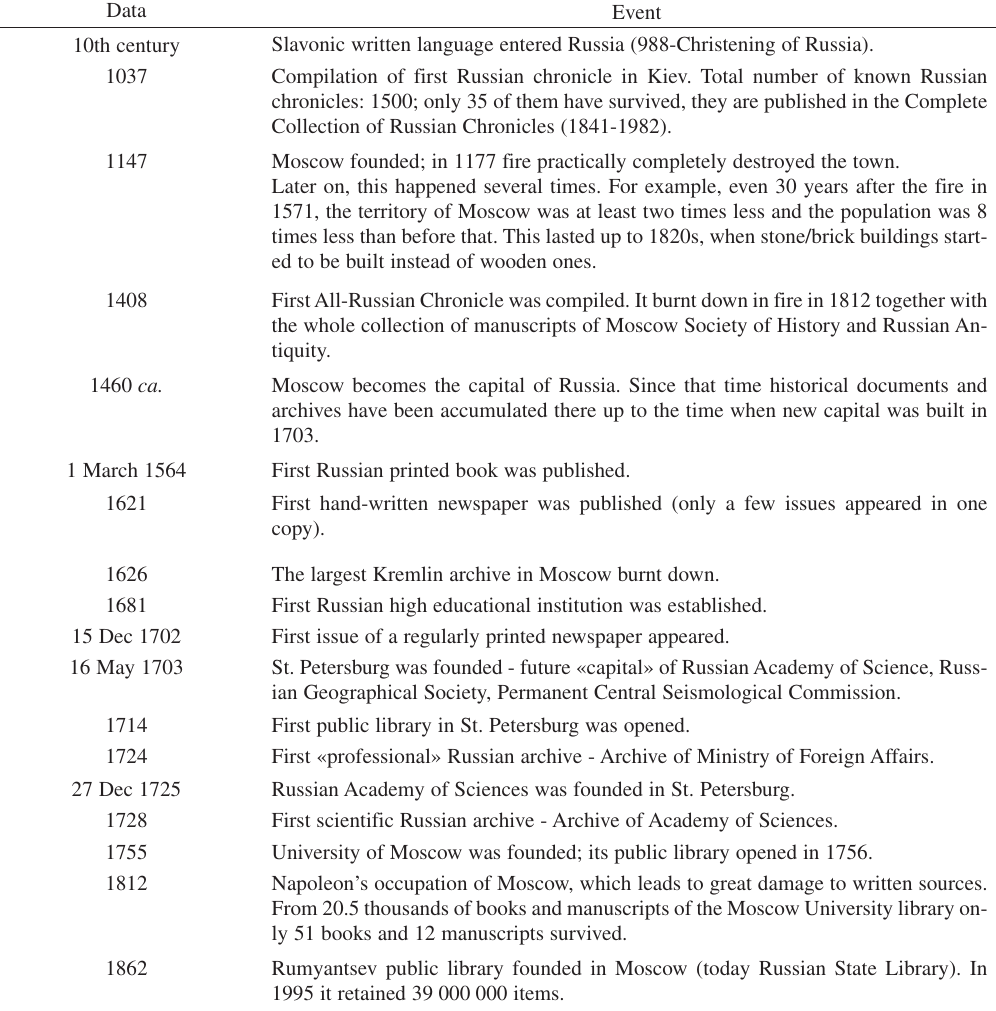
Table I. Social and cultural events in Russia affecting the historical earthquake